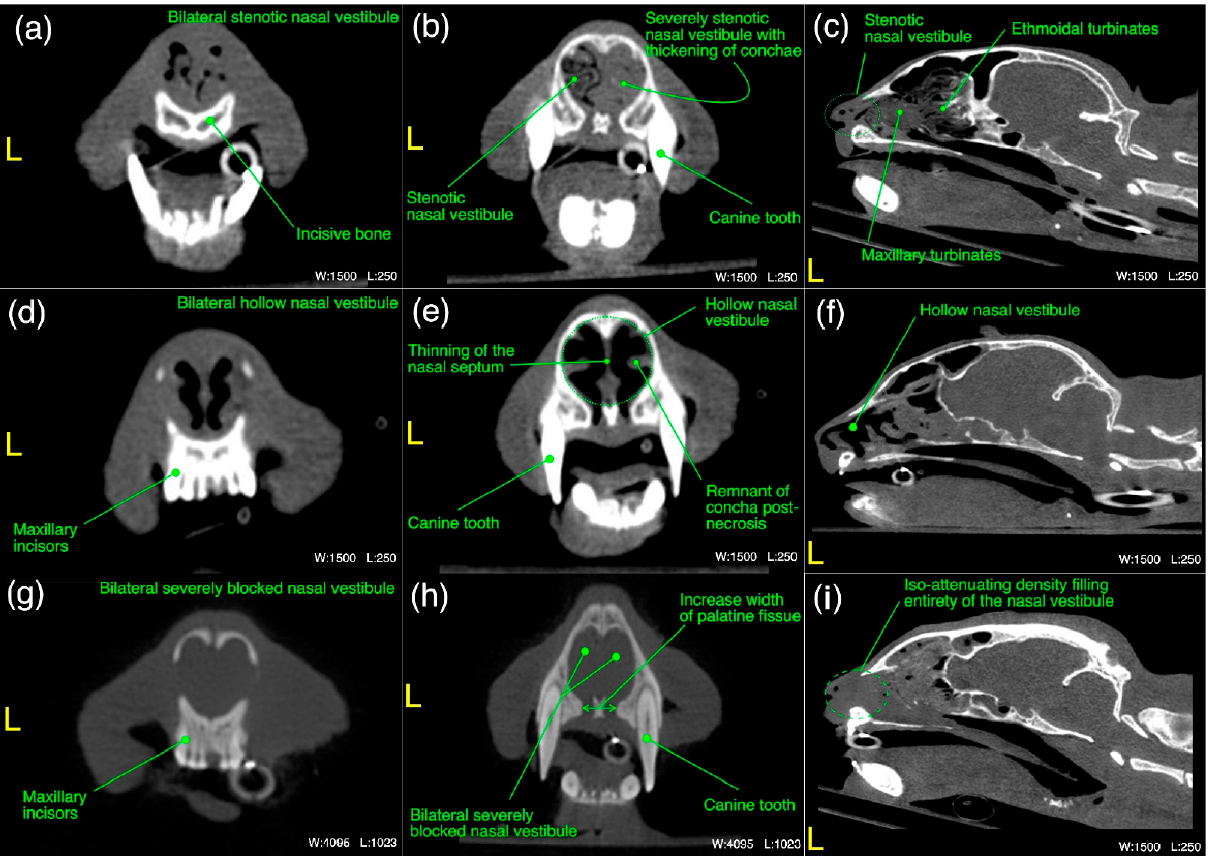
Figure 8. ( a – i ) A variety of computed tomographic changes of nasal vestibule region are labeled for pathologies related to acute/chronic infectious respiratory disease signs in Cats 1, 10 and 20. Window, level and laterality are also labeled for each section.